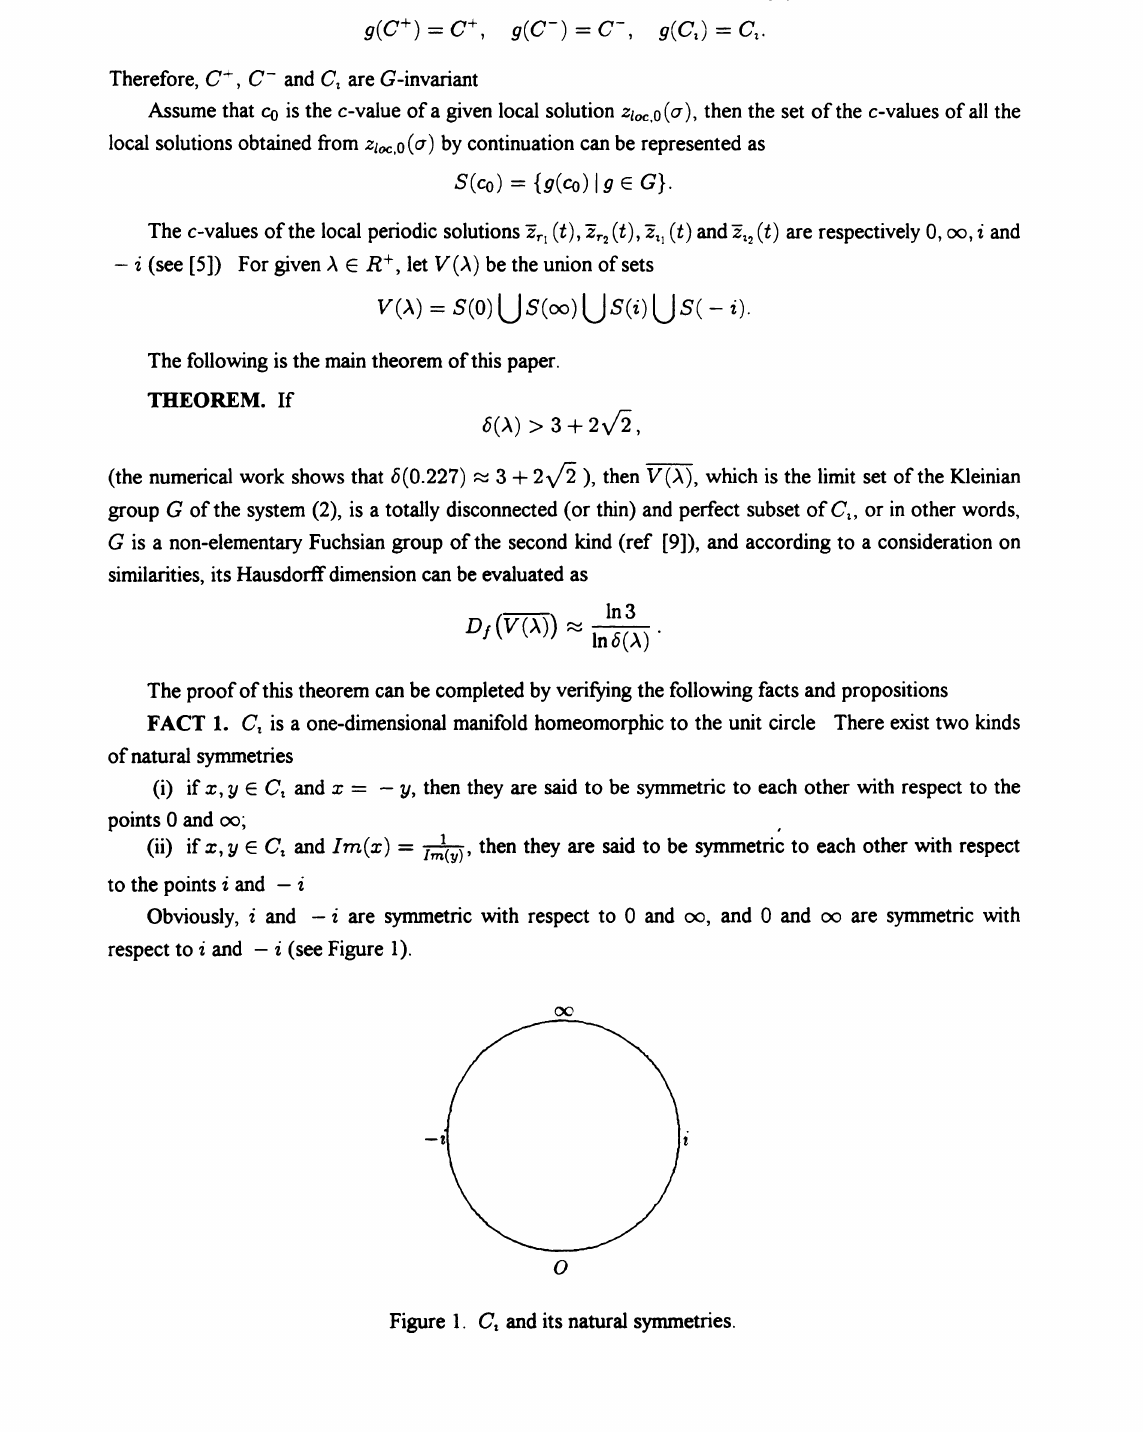
Figure 1. (7, and its natural